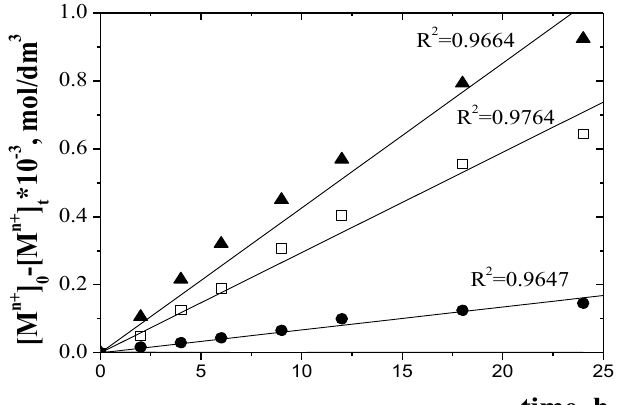
Figure 10. Relationship of [M n+ ] 0 -[M n+ ] t from time for Zn(II) ( ▲ ), Cr(III) (□), and Ni(II) (●) transport across PIMs doped with EDAB-acac.